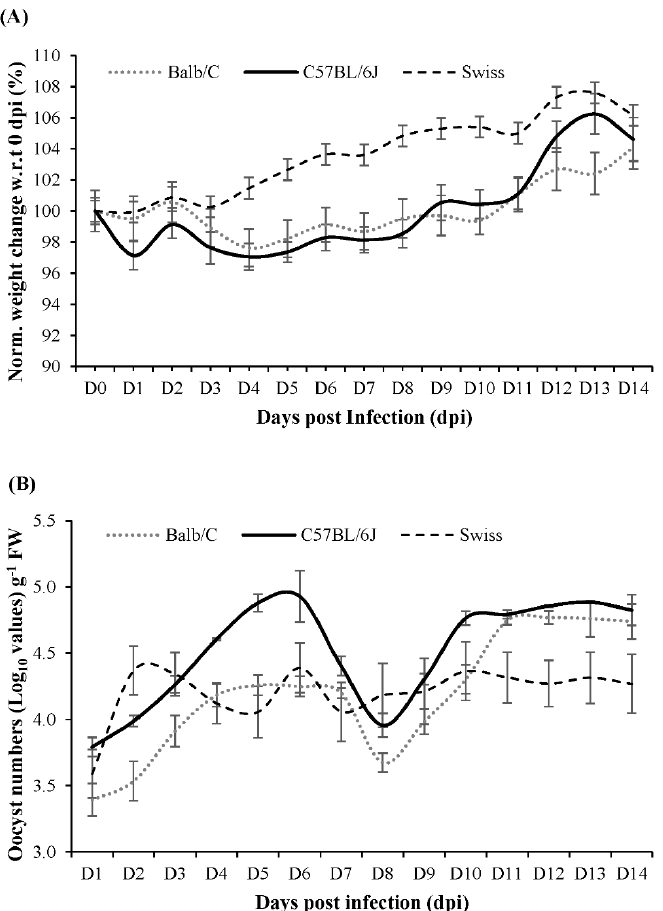
Figure 1. ( A ) Daily percentage weight change (normalized with respect to 0 dpi) in Balb/C, Swiss and C57BL6/J mice that were infected with C. parvum and monitored for 14 dpi ( B ) C. parvum count (Log 10 growth in terms of oocyst count), per gram fresh weight of faeces. The error bars indicate standard deviation ( n = 3, p -value ≤ 0.05).